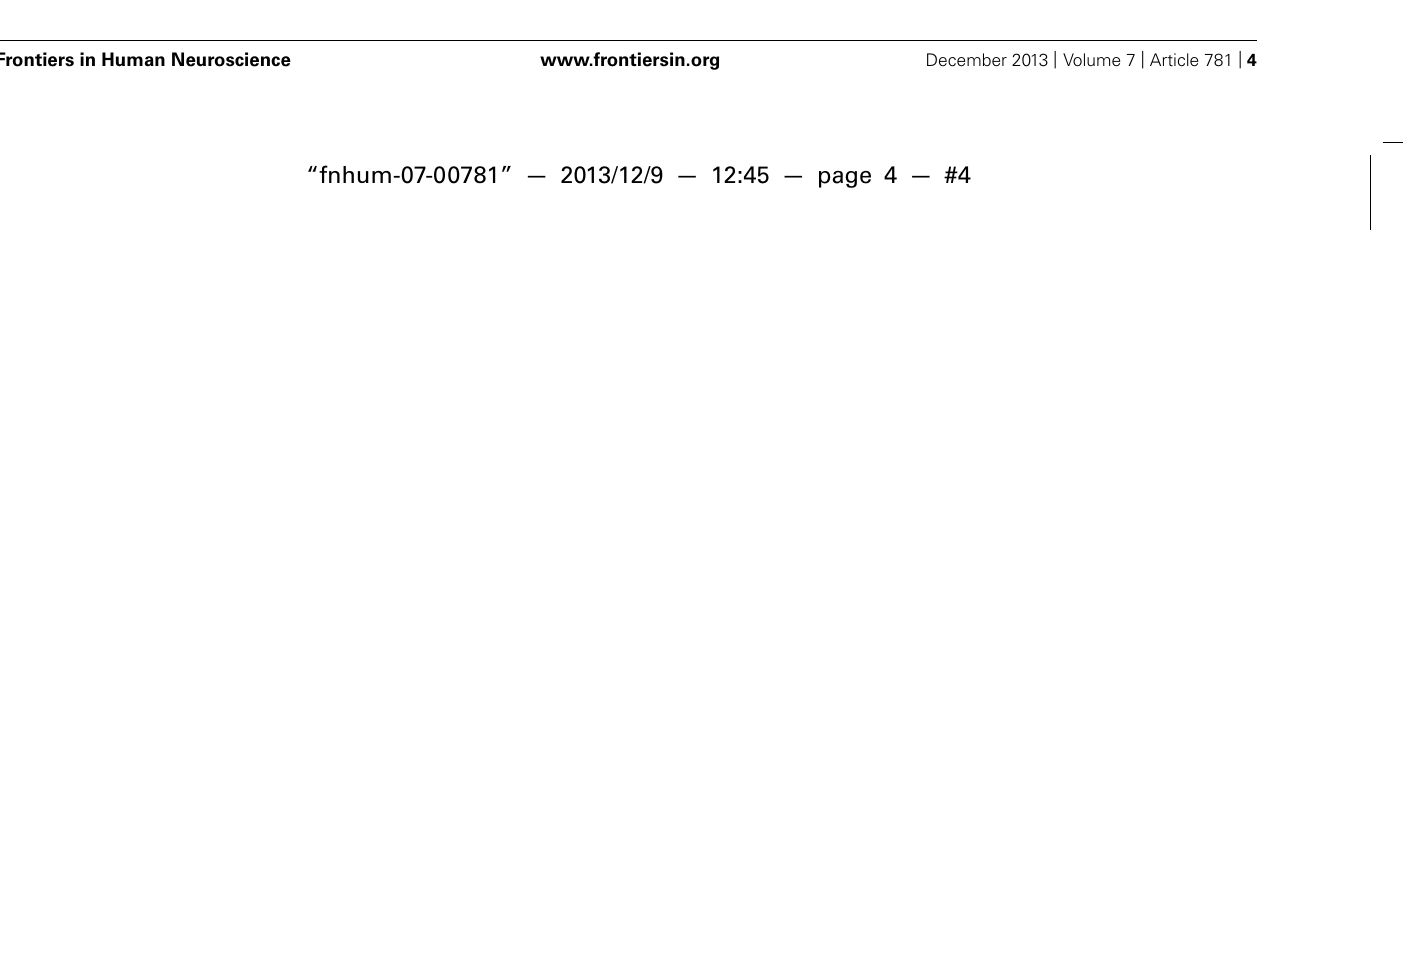
the perimeter of the electrolytic region. Sham control animals underwent an identical surgical procedure with the exception that no current was passed through the stimulating electrode. Coronal section from Paxinos and Watson